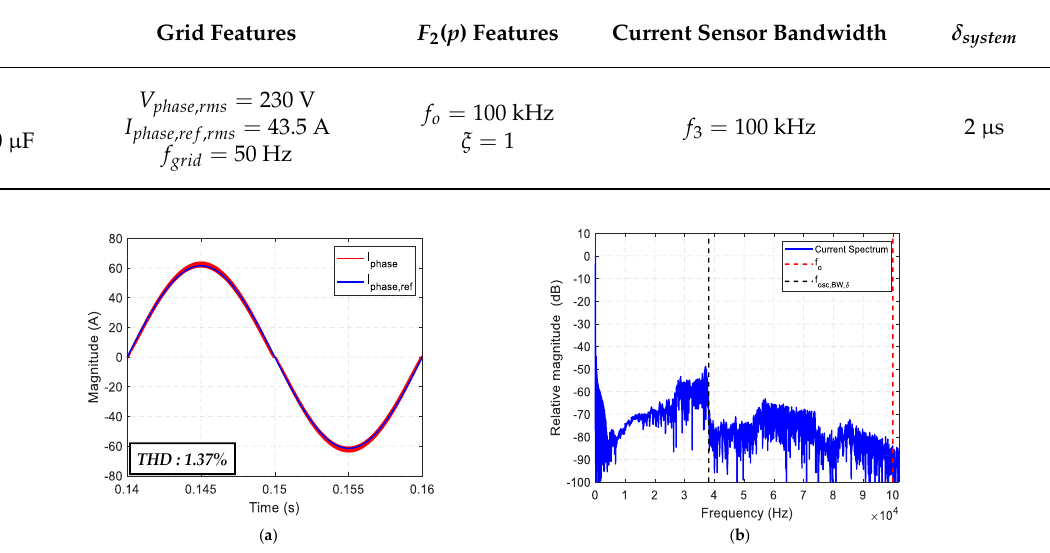
Figure 9. ( a ) Input current controlled by digital DPSSOCC and ( b ) its related current spectrum.